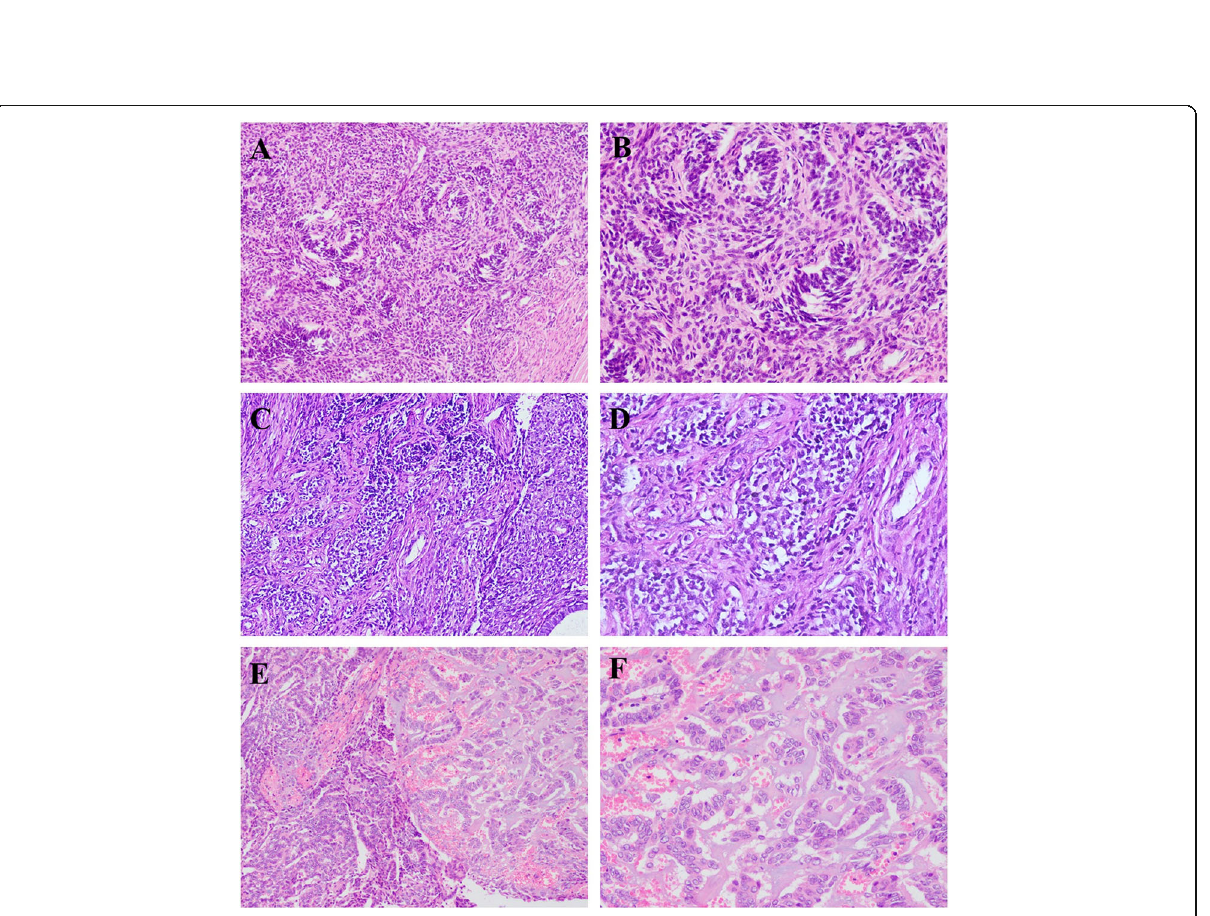
Fig. 2 Hematoxylin-eosin staining pictures of LGESS, AS and CHEC. ( a - b ) sex cord-like elements in LGESS; ( c - d ) sex cord-like elements in AS; ( e - f ) sex cord-like elements in CHEC (Hematoxylin-eosin staining, a , c , e : × 100, b , d , f : ×